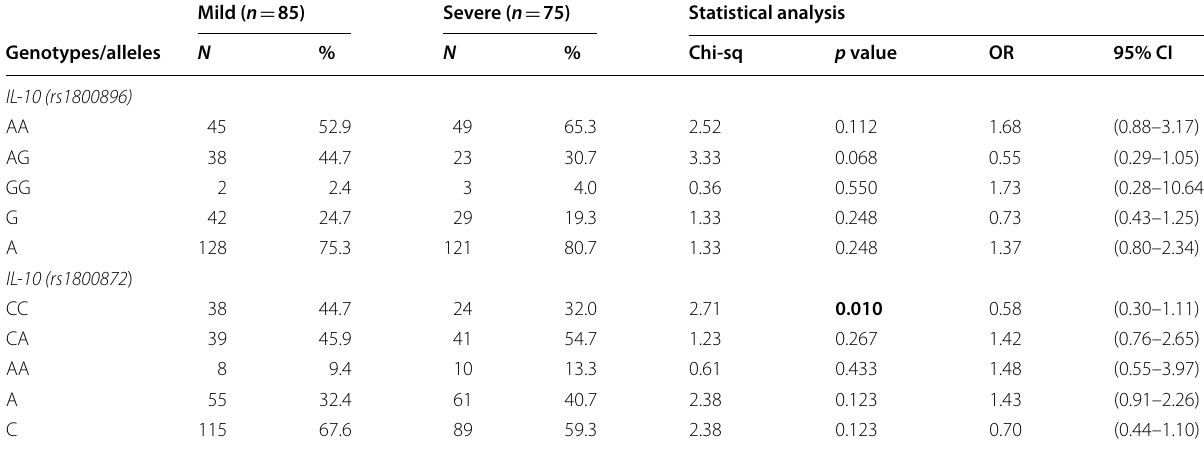
Statistically signficant values are shown in